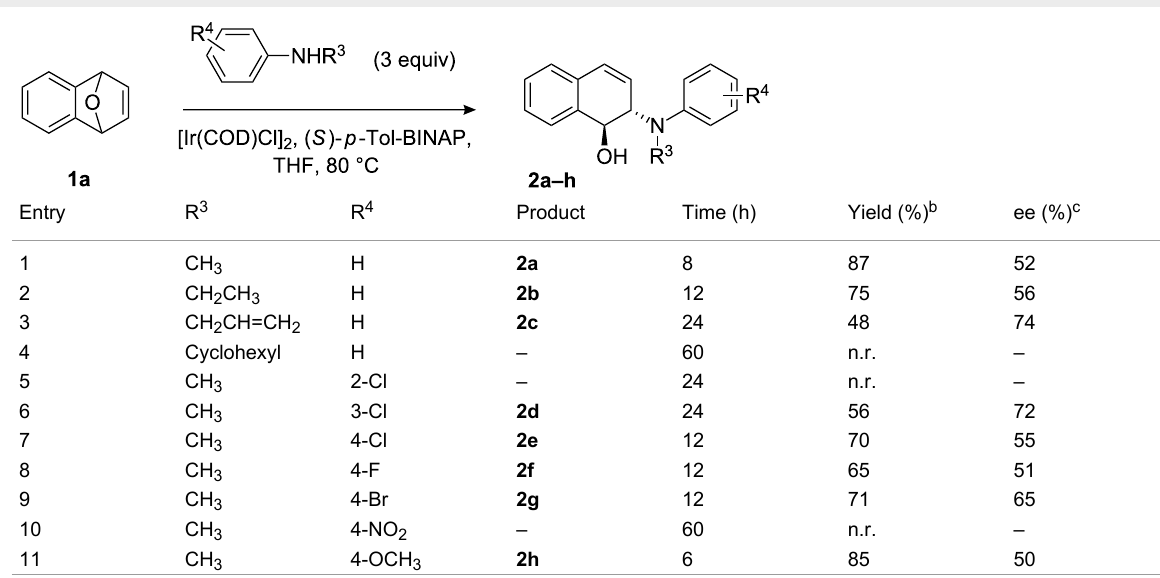
Table 2: Scope of ring-opening of oxabenzonorbornadiene 1a with substituted N -alkylaniline.